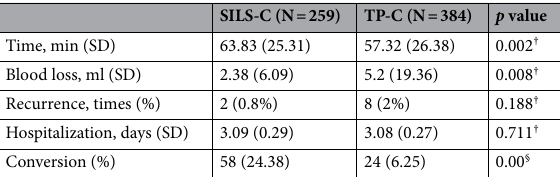
Table 2. Surgical outcomes. † Student t test. § Chi-Square.